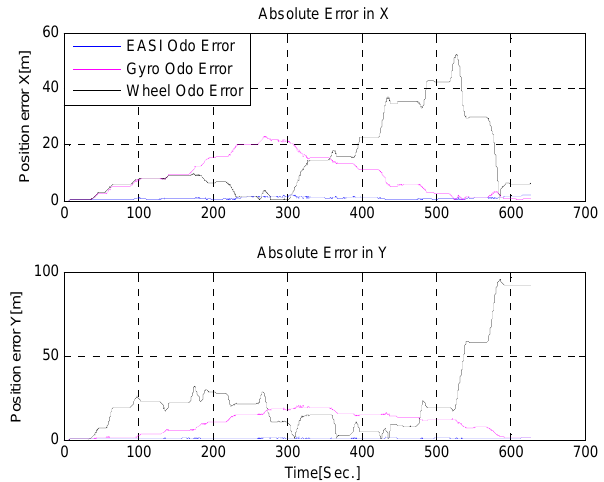
Figure 27. Absolute error in position estimation.